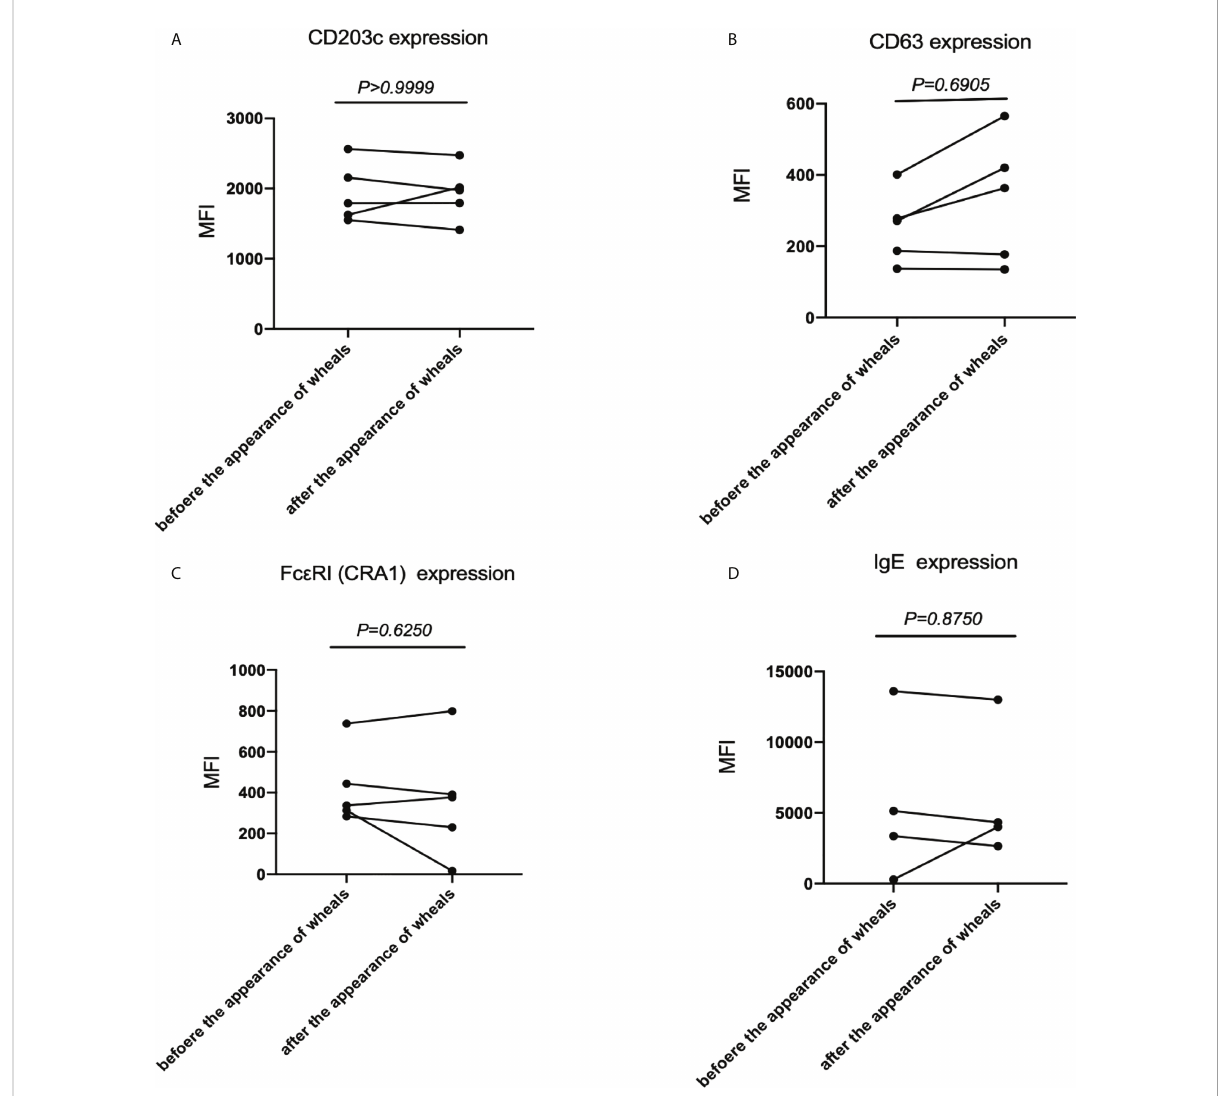
FIGURE 3 CD203c, CD63, IgE and Fc ϵ RI levels at steady state before and after the appearance of wheals in patients with CholU as a subgroup of CIndU. Comparison of (A) CD203c expression on basophils, (B) CD63 expression on basophils, (C) Fc ϵ RI expressions on basophils, and (D) IgE expressions on basophils before and after the appearance of wheals. Statistical analysis was performed by Wilcoxon